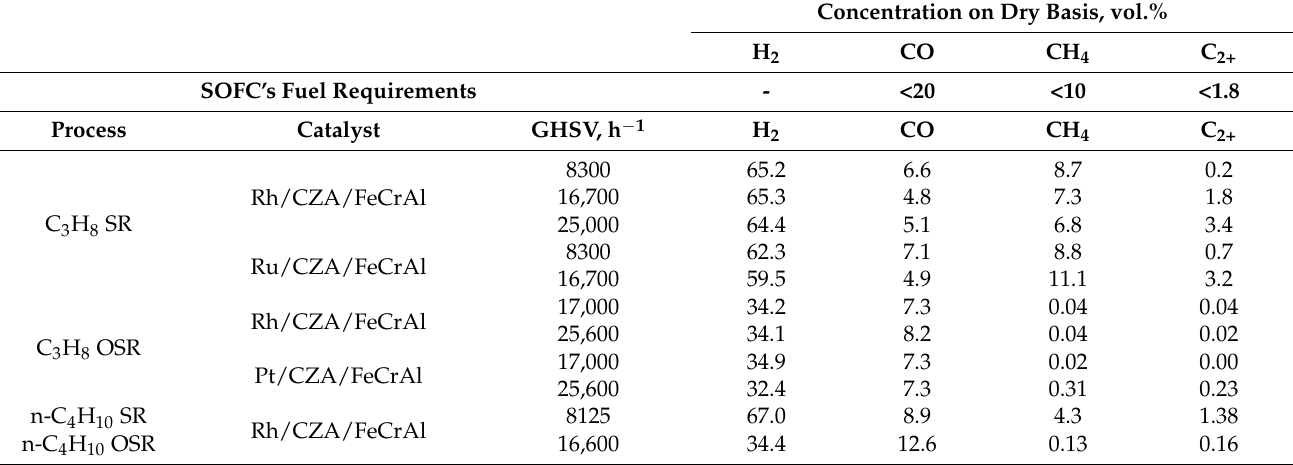
Table 4. Comparison of the requirements for the SOFCs fuel and the compositions of the syngases obtained over the M/CZA/FeCrAl. Concentration on Dry Basis,